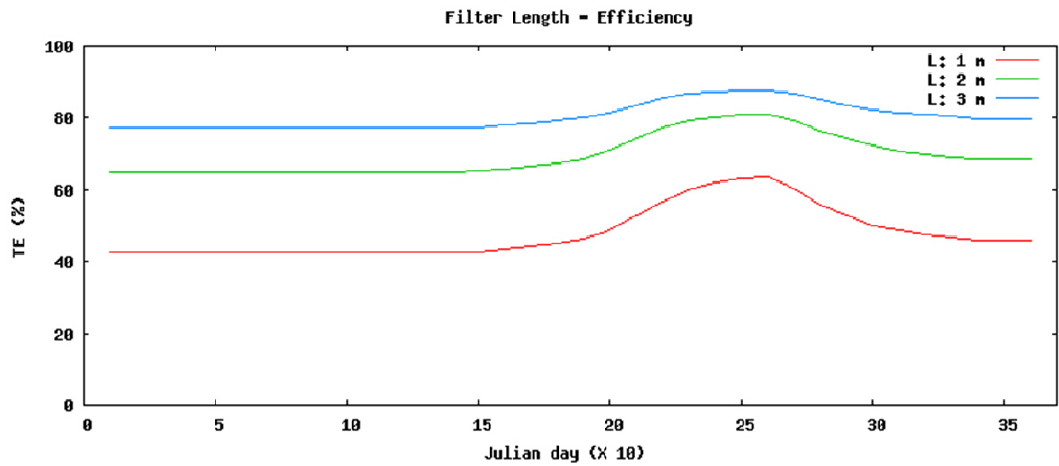
Figure 13. Trapping efficiency under three filter strip width